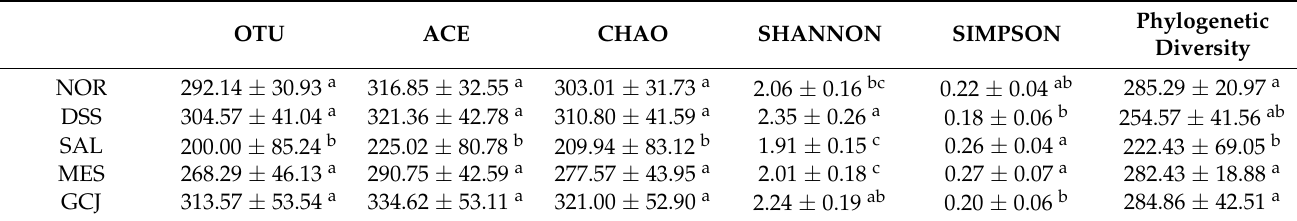
Table 3. Effects of Gochujang on diversity indexes of the gut microbiota in DSS-treated rats.